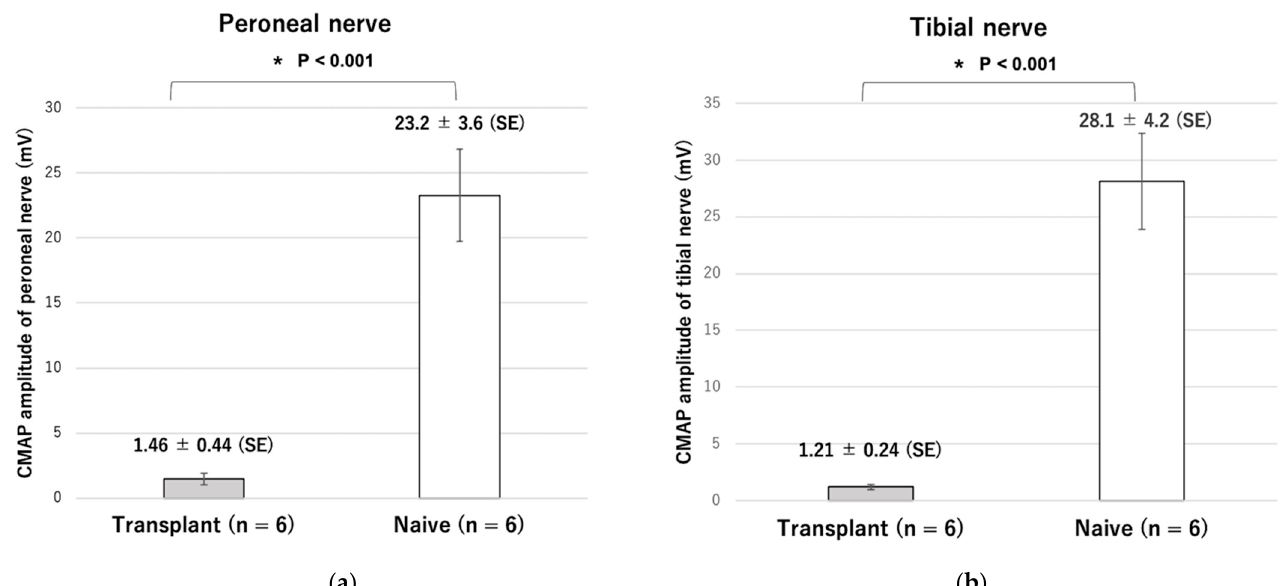
Figure 6. Amplitude of the compound muscle action potential (CMAP) of the ( a ) peroneal nerve and ( b ) tibial nerve. * P<0.05